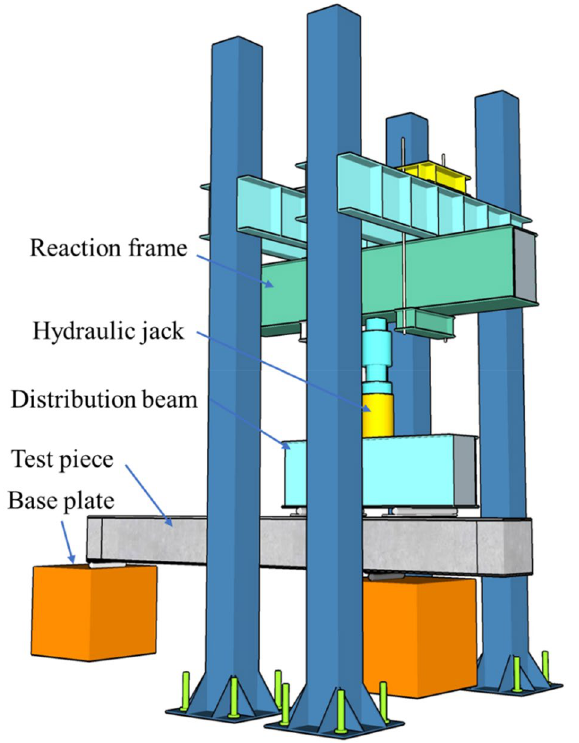
Figure 2. Schematic diagram of test loading.